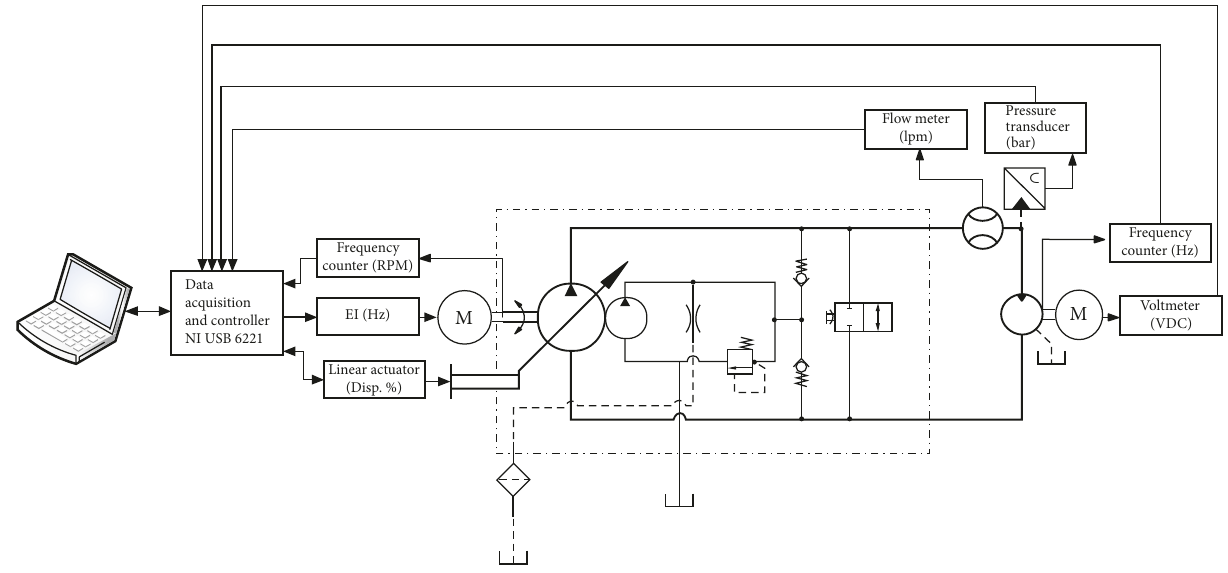
Figure 4: Schematic representation of test bench hardware setup.